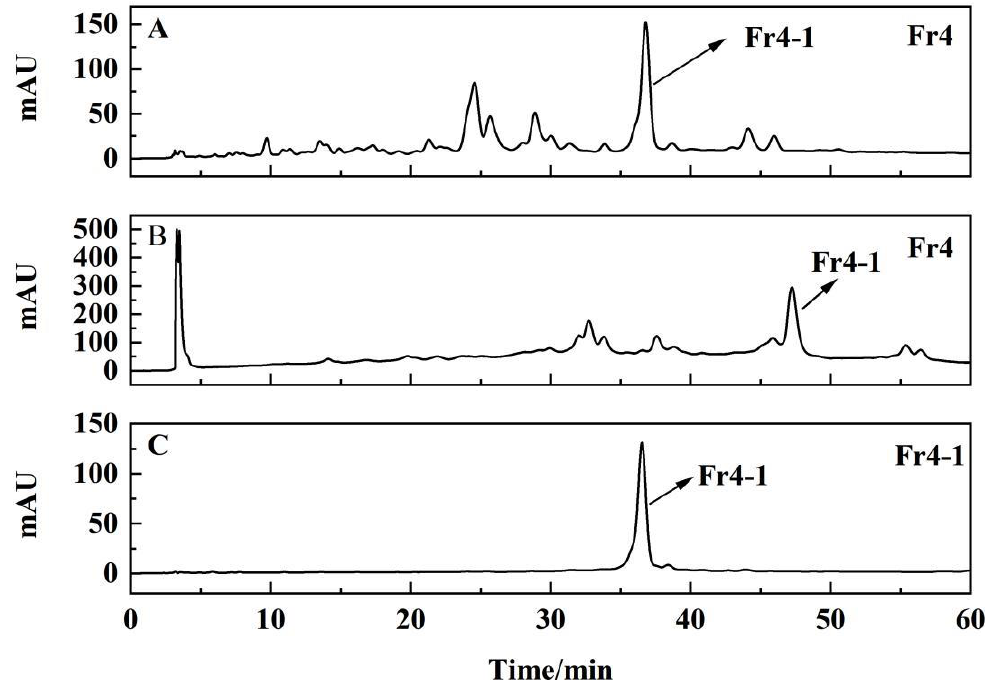
Figure 3. The first-dimensional analysis ( A ), preparation ( B ) of Fr4 and HPLC analysis of Fr4-1 ( C ) using the Megres C18 analytical and preparation columns.